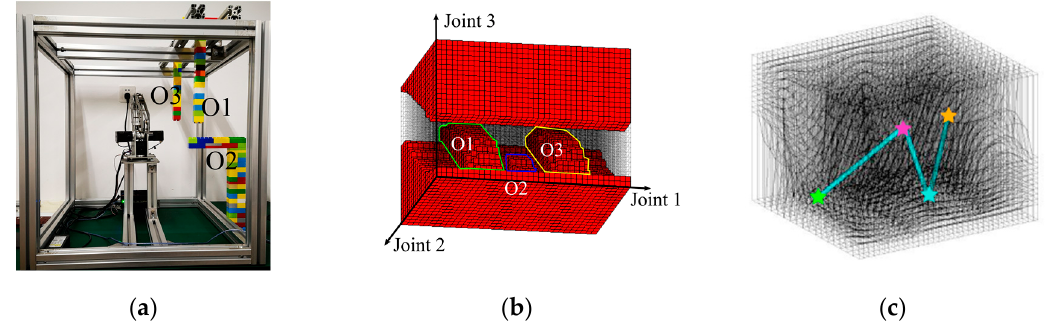
Figure 17. The setup of the first experimental environment, O1, O2, and O3 respond to the corresponding obstacles. ( a ) The setup of the environment. ( b ) The configuration space of the first environment. ( c ) The distorted configuration space. The start point is colored by green, and the target point is colored by yellow. Two passing points are colored by purple and blue,